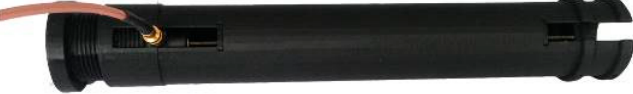
Figure 7. Waveguide bars.